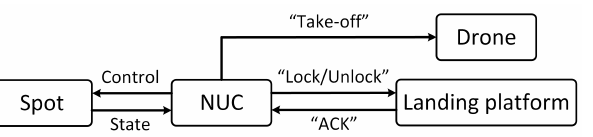
Figure 10. Communication architecture for the proposed legged-aerial system.